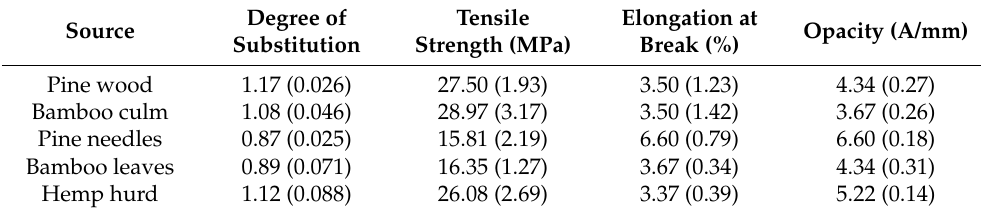
Table 2. Characteristics of CMCs and CMC films produced from different cellulosic sources.